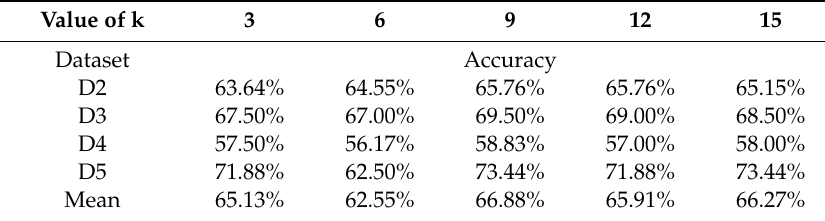
Table 5. Prediction performance of K-nearest neighbor (KNN) for the testing dataset.